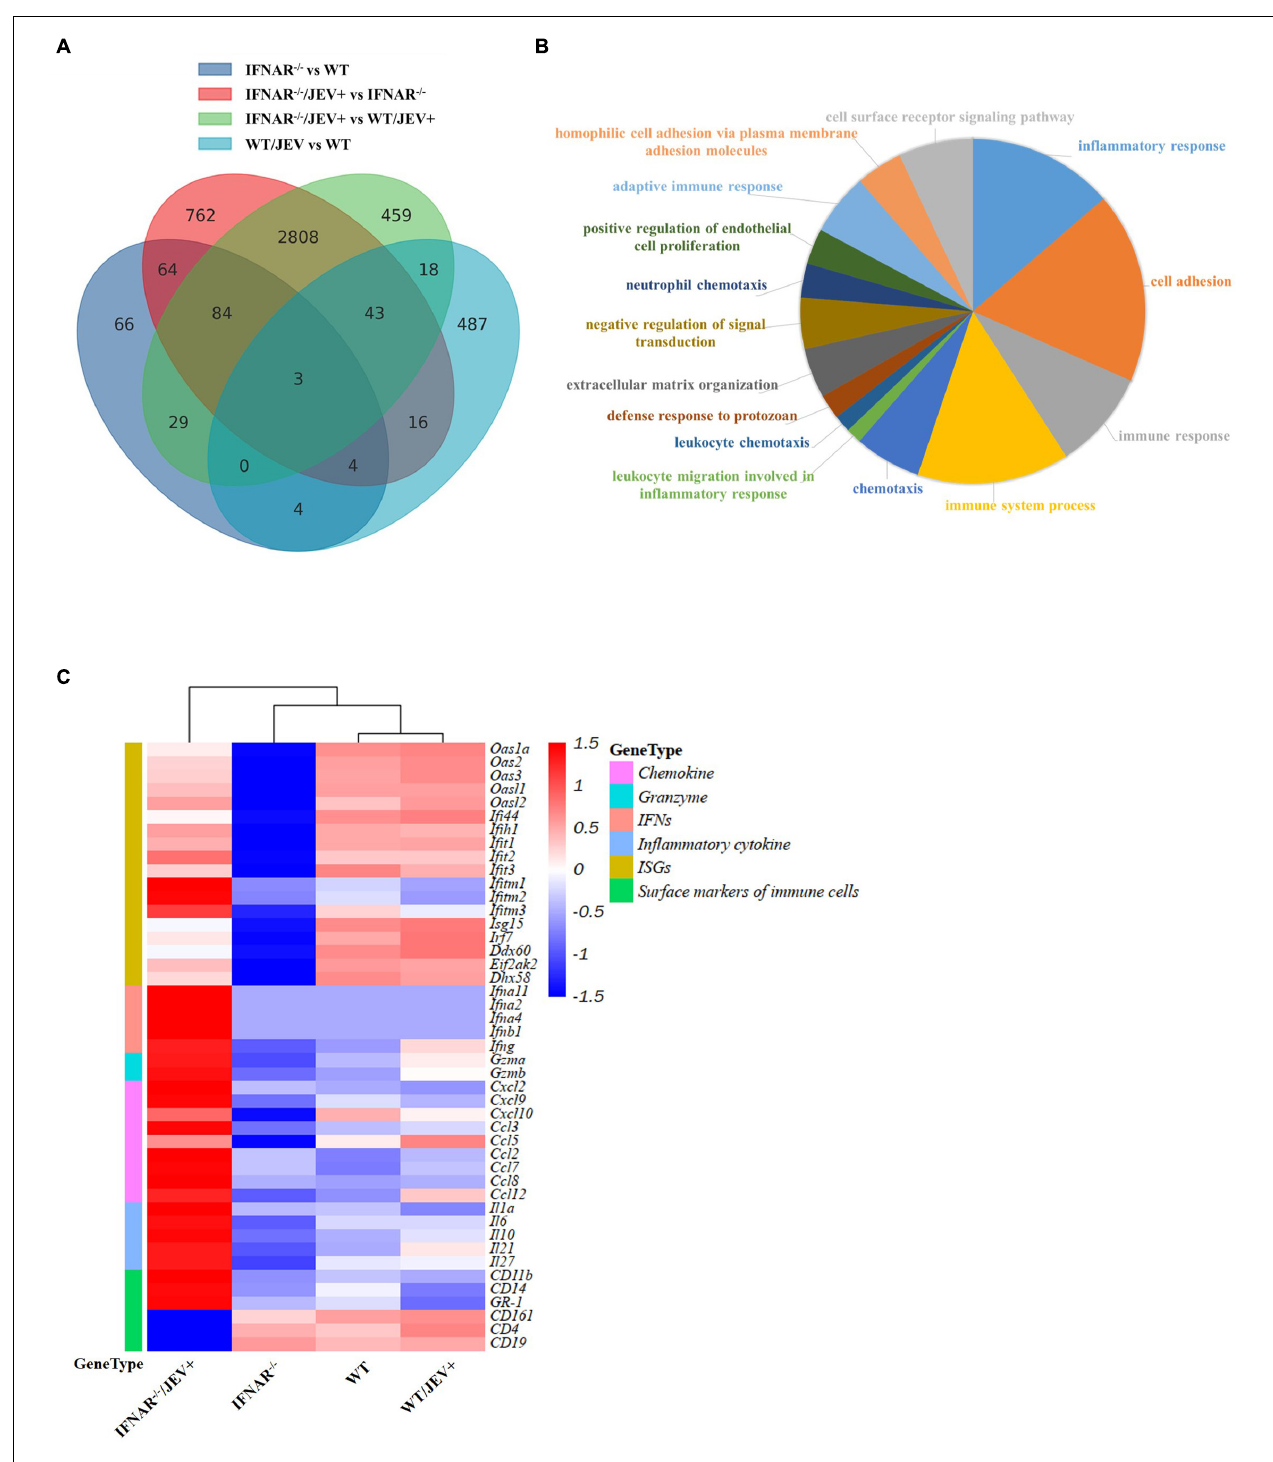
FIGURE 3 | The transcript profile analysis of spleen in WT and IFNAR − / − mice infected with SA14-14-2. (A) Venn diagram depicting the differentially expressed genes unique or common at comparable groups mock-IFNAR − / − mice vs. mock-WT mice, infected-IFNAR − / − mice vs. mock-IFNAR − / − mice, infected-IFNAR − / − mice vs. infected-WT mice, and infected-WT mice vs. mock-WT mice. (B) Enriched Gene Ontology terms in the biological process category among common genes only was comparable in groups infected-IFNAR − / − mice vs. mock-IFNAR − / − mice and infected-IFNAR − / − mice vs. infected-WT mice. The corresponding color section represented the different biological processes. (C) Heat map analysis of differentially expressed key genes related to immune response. Each row showed the relative expression level for a single gene, and each column showed the average expression level of three biological repetition samples.